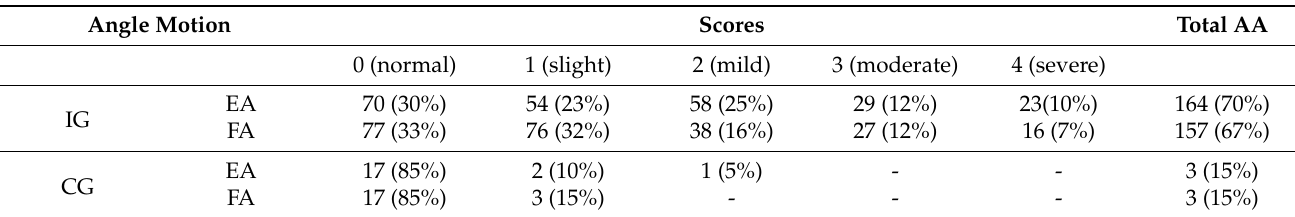
Table 2. Distribution in frequency (n.) and percentage (%) of the extension and flexion angle scores in both the CCL injury group and the control group.